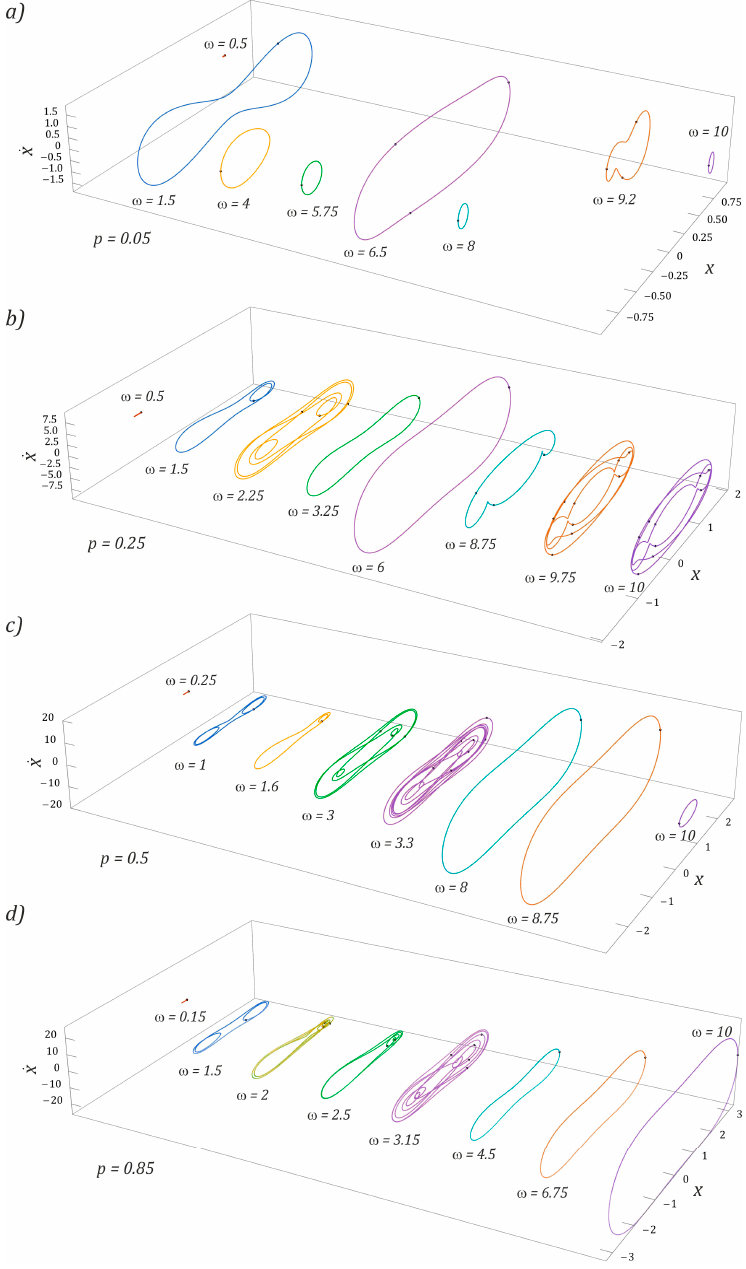
Figure 8. Examples of periodic responses of a BEH system identified for dimensionless mechanical vibration amplitudes: ( a ) p = 0.05, ( b ) p = 0.25, ( c ) p = 0.5, and ( d ) p = 0.85 (see the shape and size of the corresponding phase portrait (𝑥,𝑥(cid:4662)) ). ω , p , x, and 𝑥(cid:4662) are dimensionless.